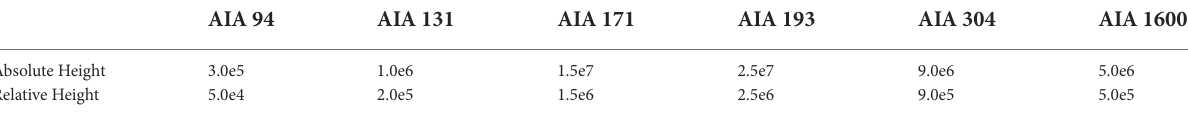
TABLE 1 Parametersforthe find_peaks routine.Heightistheminimumpeakheighttobeconsidered,andrelativeheightistheminimumrelativeheight fromstarttopeak.Thesewerechosenbasedonaconservativelylowthresholdfordetecting ≥ C 1flaresandwerefoundtogiverobustresults.